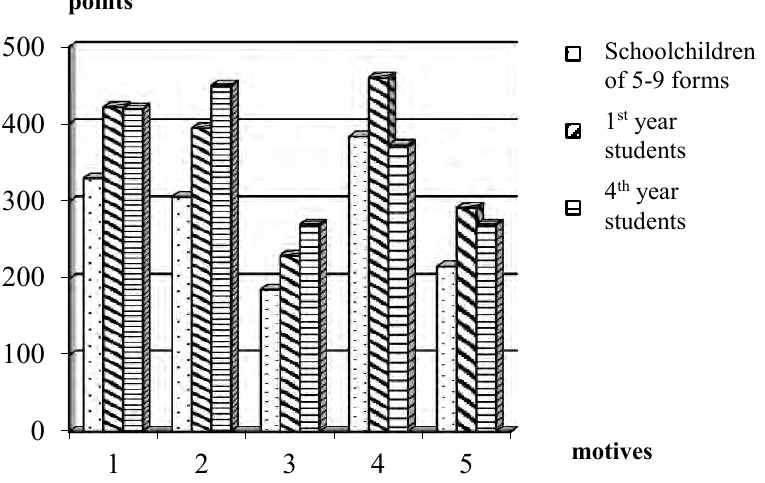
Fig.1. Results of schoolchildren’s and 1 st and 4 th year students’ questioning of health motives for practicing